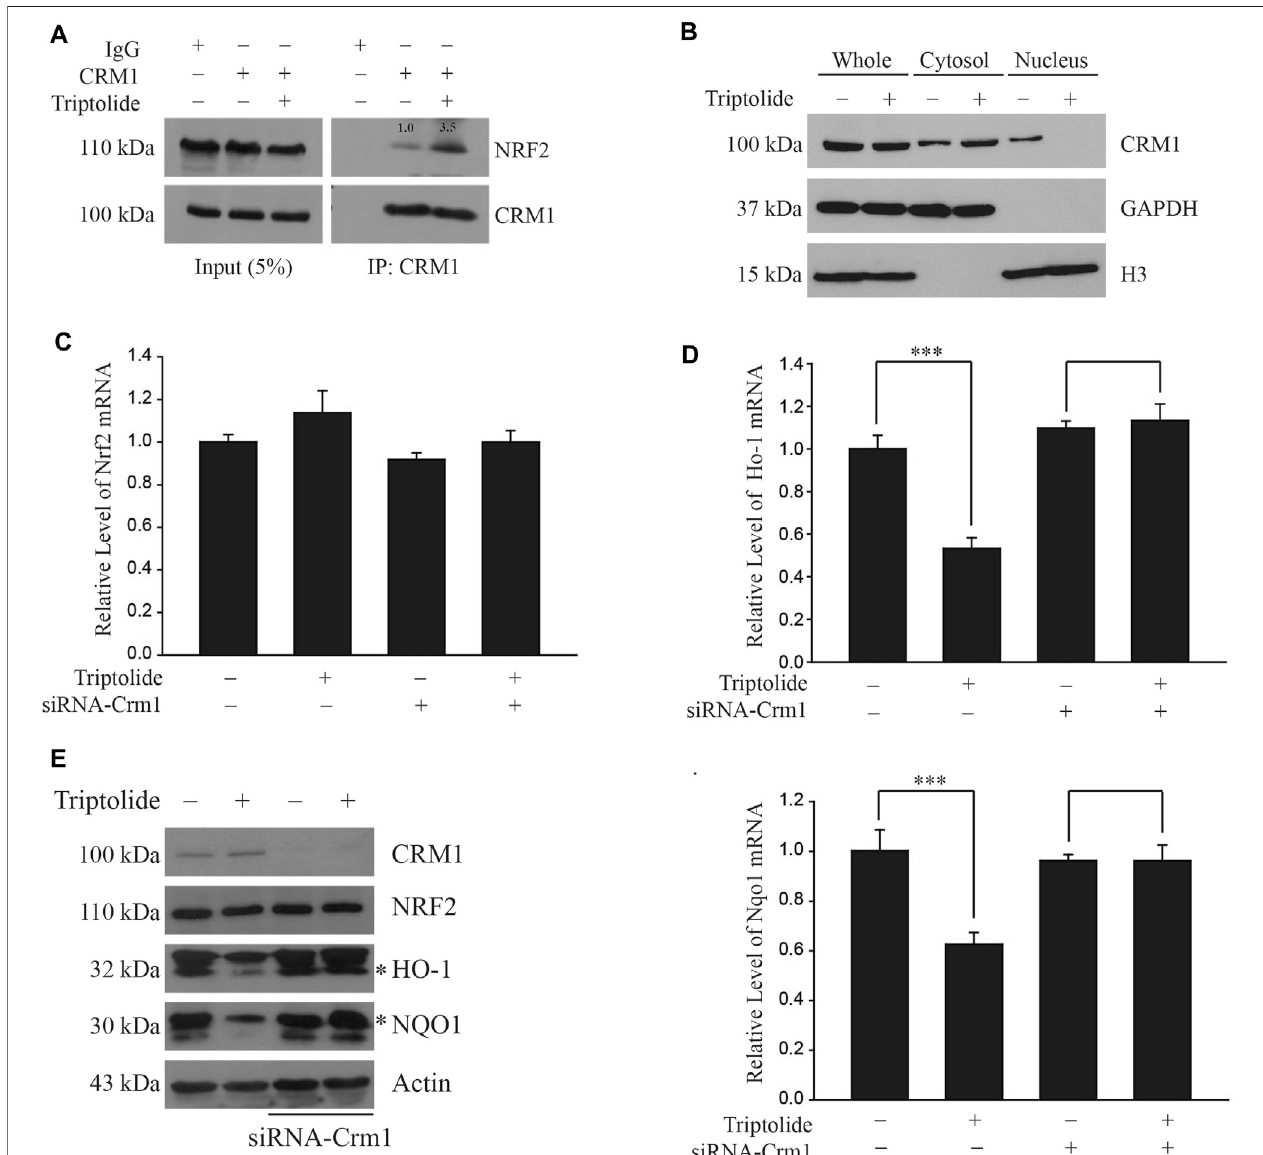
FIGURE 4 | Triptolide promotes the interaction between NRF2 and CRM1 in A549 cells. (A) Triptolide promotes the endogenous interaction between NRF2 and CRM1 in A549 cells. A relative density of bands is illustrated inside the fi gure. A549 cells were seeded in 100 mm culture plates (2 × 10 6 cells) and exposed to triptolide (20 nM) for 24 h. Cell lysates were collected and incubated with IgG (1 μ g) or CRM1 antibody (1 μ g) overnight at 4 ° C. After immunoprecipitation with protein A/G beads, the samples were washed with NP-40 lysis buffer and Western blot analysis was performed against NRF2 and CRM1. (B) Triptolide increases cytoplasmic localization of CRM1 in A549 cells. A549 cells were seeded in 100 mm culture plates (2 × 10 6 cells) and exposed to triptolide (20 nM) for 24 h. After separation of the cytosol and the nucleus, Western blot analysis was performed against CRM1. GAPDH and H3 were used as markers for the cytosol and the nucleus, respectively. (C) TriptolidedoesnotaffectthelevelofNrf2mRNAregardlessofCRM1.A549cellswereseededin60 mmplates(2.0 × 10 5 cells)andexposedtotriptolide(20 nM)for3 hin the absence or presence of siRNA against Crm1 (100 nM). Total RNA was prepared and real-time RT-PCR was performed using Nrf2 ]speci fi c primers ( n (cid:2) 4). (D) Suppression of transcription of Ho-1 (Left Panel) and Nqo1 (Right Panel) by triptolide is dependent on CRM1. A549 cells were seeded in 60 mm plates (2.0 × 10 5 cells) and exposed to triptolide (20 nM) for 3 h in the absence or presence of siRNA against Crm1 (100 nM). Total RNA was prepared and real-time RT-PCR was conducted using speci fi c primers against Ho-1 and Nqo1. Asterisks indicate a statistical signi fi cance ( n (cid:2) 4): *** p < 0.01. (E) Suppression of HO-1 and NQO1 by triptolide is dependent on CRM1. A549 cells were seeded in 60 mm plates (2.0 × 10 5 cells) and exposed to triptolide (20 nM) in the absence or presence of siRNA against Crm1 (100 nM) for 24 h. Cell lysates were collected and Western blot analysis was performed.